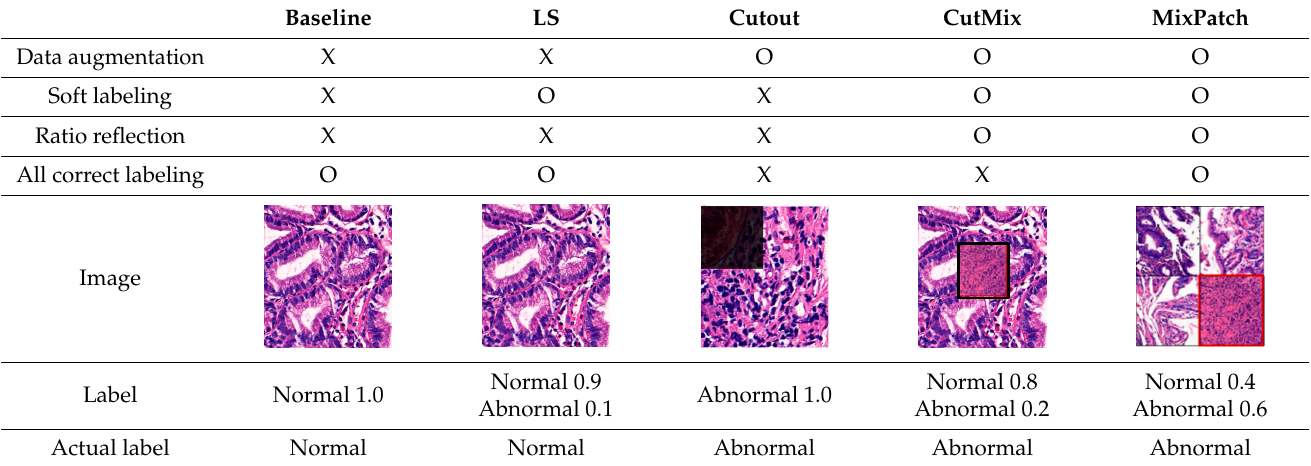
Table 2. Summary of the compared methods.